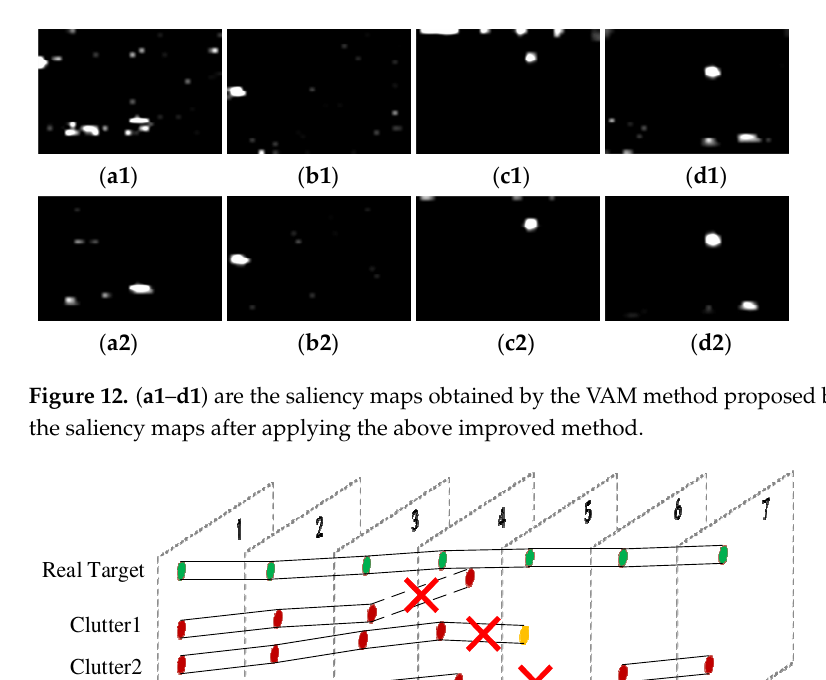
(d) 0.0612 Figure 11. Intensity standard deviation under different sea wave background. In contrast, the minimum standard deviation of the intensity of the non-uniform background is 0.1363. Therefore, it can be found that the intensity standard deviations of the two categories of images are significantly different. The selected threshold is the aver- age of the maximum standard deviation of the smooth background and the minimum standard deviation of the rough background (threshold 0.1237). Experiments have con- firmed that it has the best experimental effect. 2.4. Real Target Judgment Stage Figure 12(a1–d1) shows the saliency map obtained by applying the VAM proposed by ITTI; (a2–d2) is the saliency maps obtained after the suspected target screening stage. It can be found that the proposed above method significantly reduces the interference of